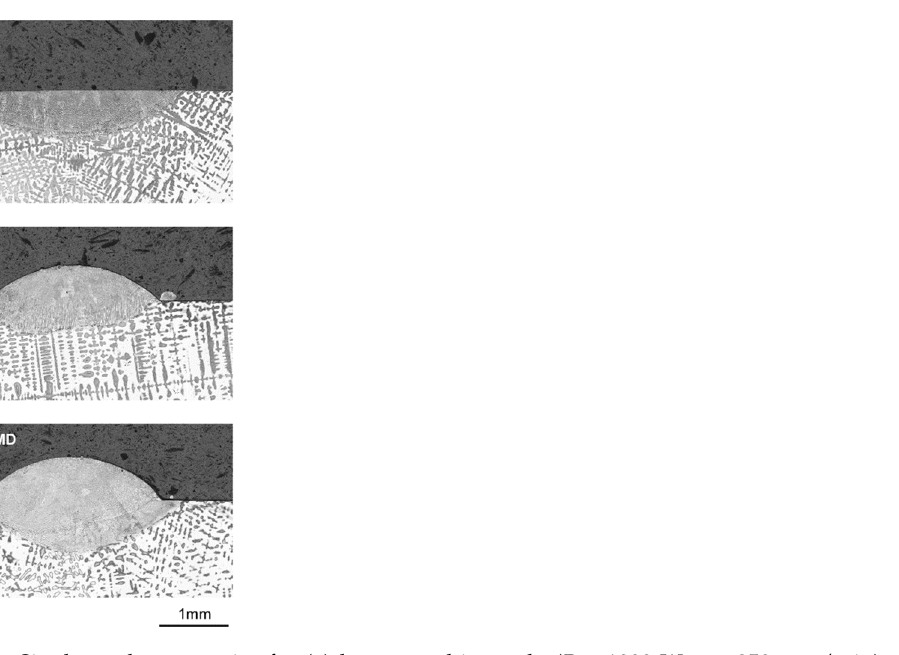
Figure 15. Single track geometries for ( a ) laser remelting only ( P = 1000 W, v = 250 mm/min), ( b ) DMD only ( P = 1000 W, m = 4.0 g/min), ( c ) laser remelting and DMD.